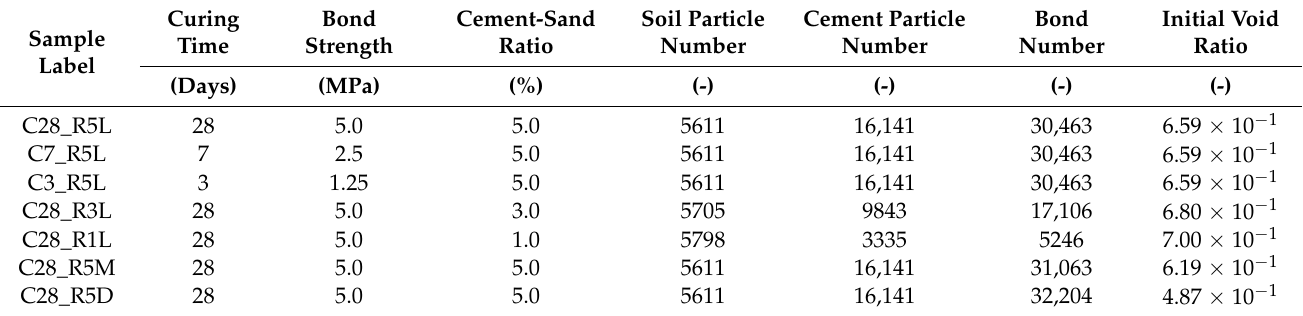
Table 2. Parameters of the samples with different initial conditions.